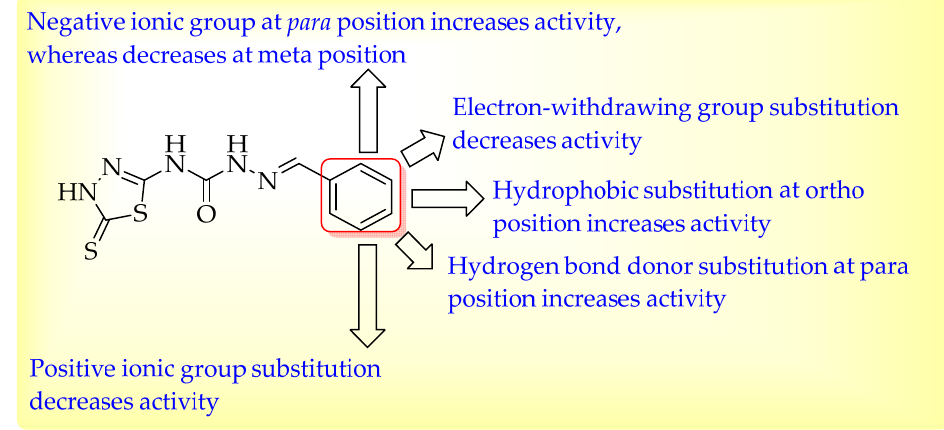
Figure 10. Optimization of ligands for the development of novel thiadiazole derivatives .